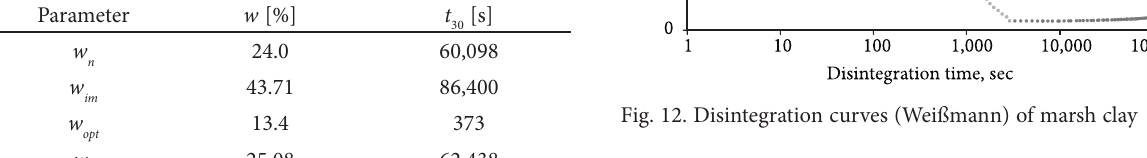
Table 10. Disintegration time t Table 11. Disintegration time t